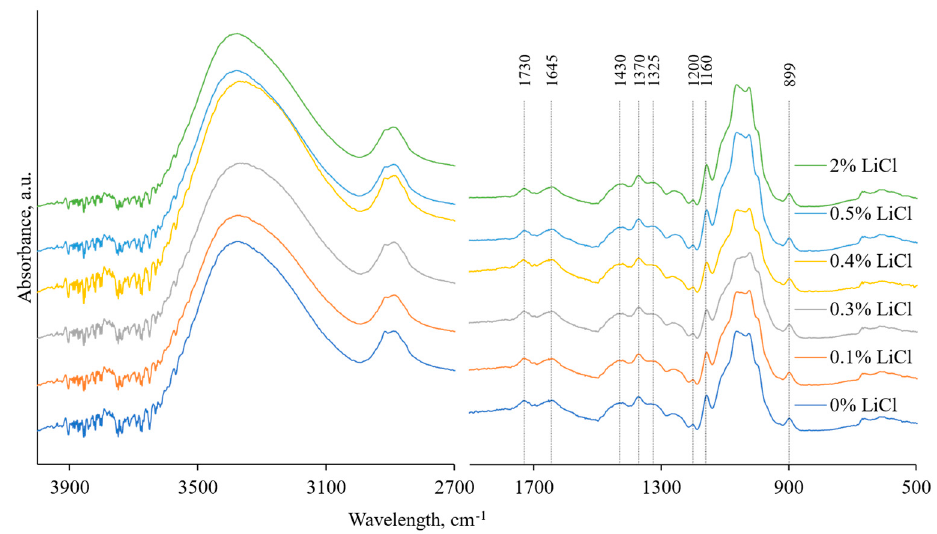
Figure 6. FTIR spectra of tested membranes were recorded using the Perkin Elmer Frontier spectrometer with a universal ATR module of diamond crystal at a resolution of 4 cm − 1 in the absorbance mode.